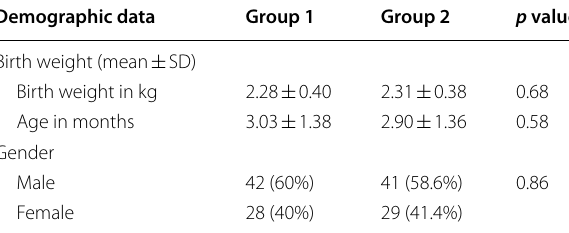
Table 2 Comparison of demographic profile of infants between two